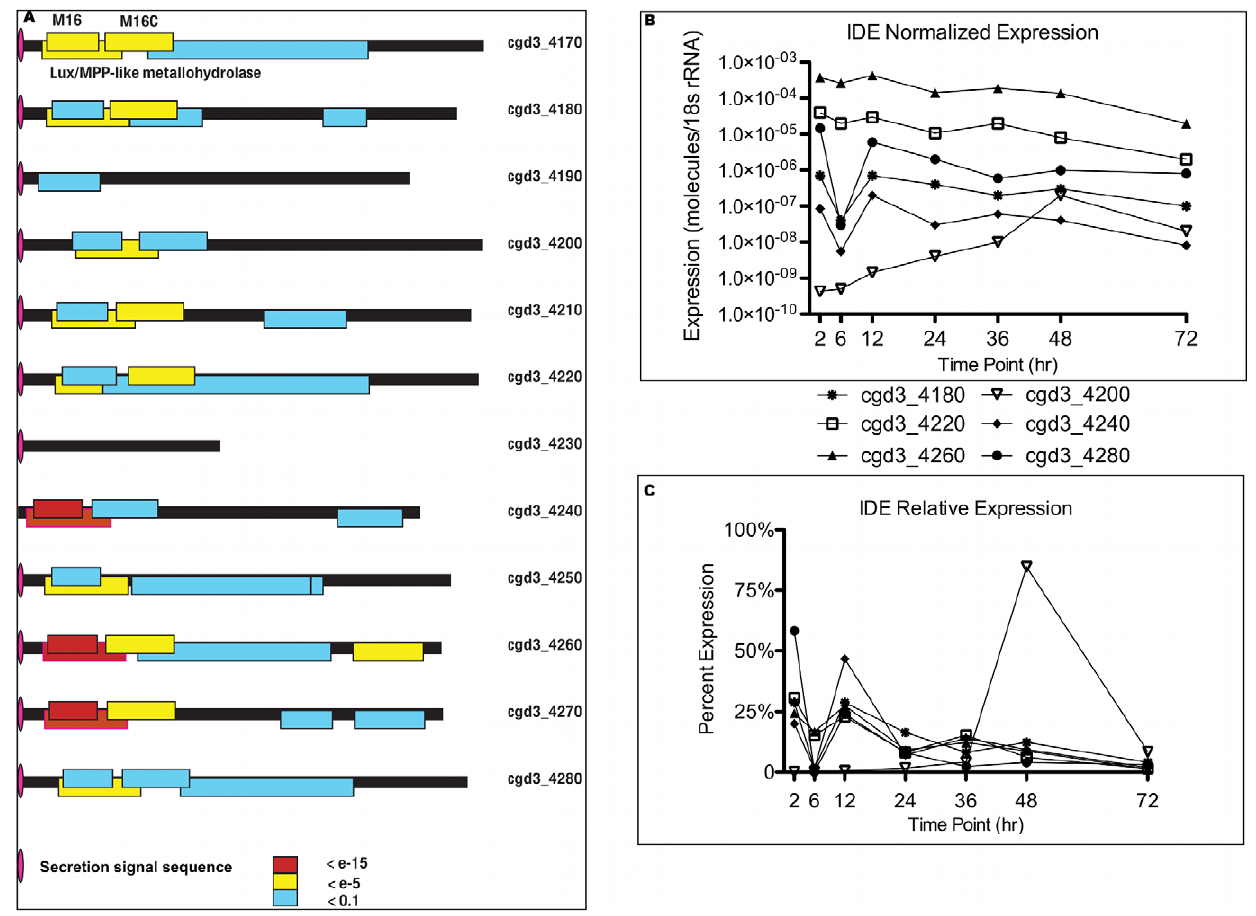
Figure 3. Chromosome 3 Peptidase Loci are not Co-expressed. Twelve genes, including 11 peptidase genes are present in tandem on chromosome 3. ( A ) The protease motifs were identified and color coded based on the conservation level. ( B ) RT-PCR for each gene was normalized to C. parvum 18S rRNA and the median for four biological replicates for the 7 time point time course is shown. ( C ) The normalized expression was then averaged by each gene’s total expression for all 7 time points.